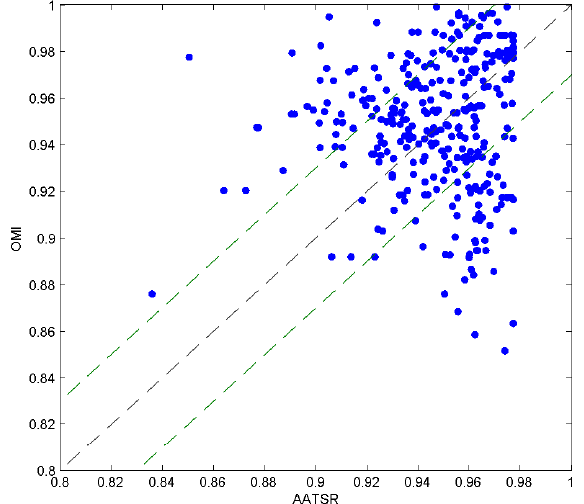
Figure 8. Comparison of AAOD derived from AATSR and AERONET data over Moscow in August